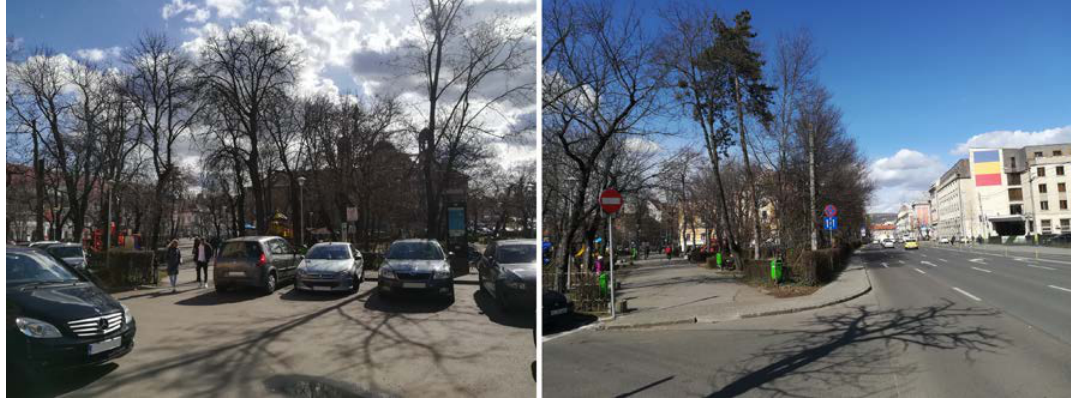
Figure 8 : Ștefan cel Mare Sq uare Source: Alexandru- Sabin NICULA,